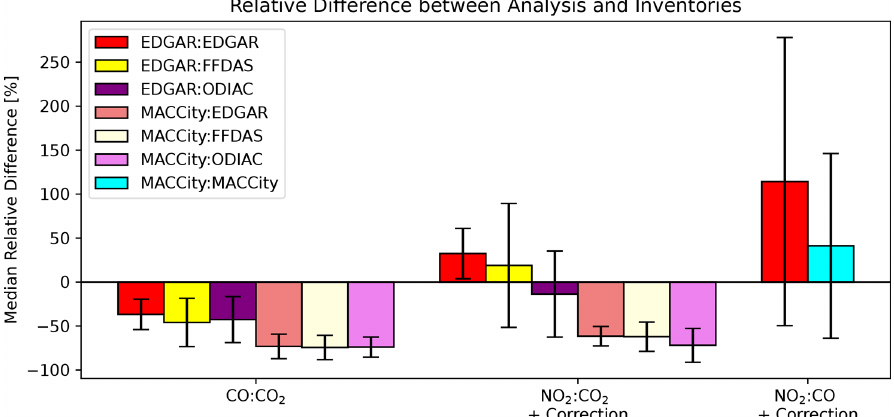
Figure 10. The median relative difference in percent between the observed enhancement ratios and those from the inventories (inven- tory − observed). The leftmost set of bars is for the CO : CO 2 enhancement ratios. The middle set of bars is for lifetime-corrected NO 2 : CO 2 enhancement ratios, and the right set of bars is for lifetime-corrected NO 2 : CO enhancement correction. The error bars show the standard deviation in the spread in inventory differences from the measurements over all cities divided by the square root of the number of